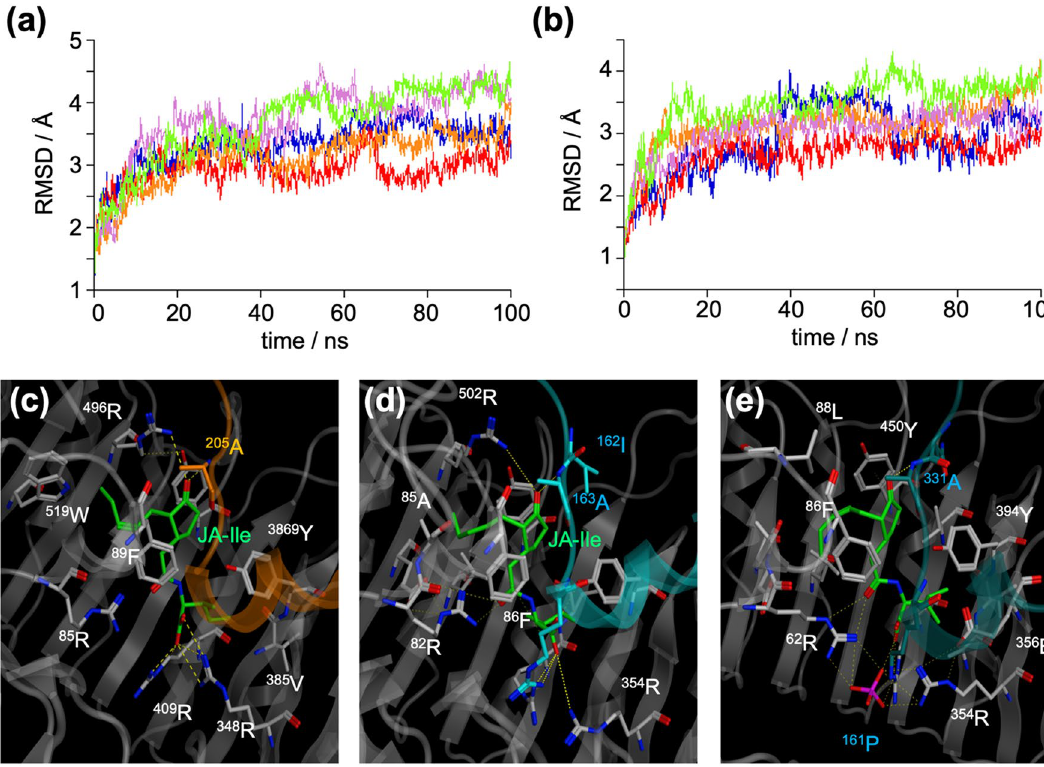
Figure 5. ( a , b ) The RMSDs of backbone atoms of the complex of Sl COI1-JA-Ile- Sl JAZ1 ( a ) and Sl COI1-JA- Ile- Sl JAZ5 ( b ) as a function of time. Each plot depicted in blue, red, orange, purple, or green was